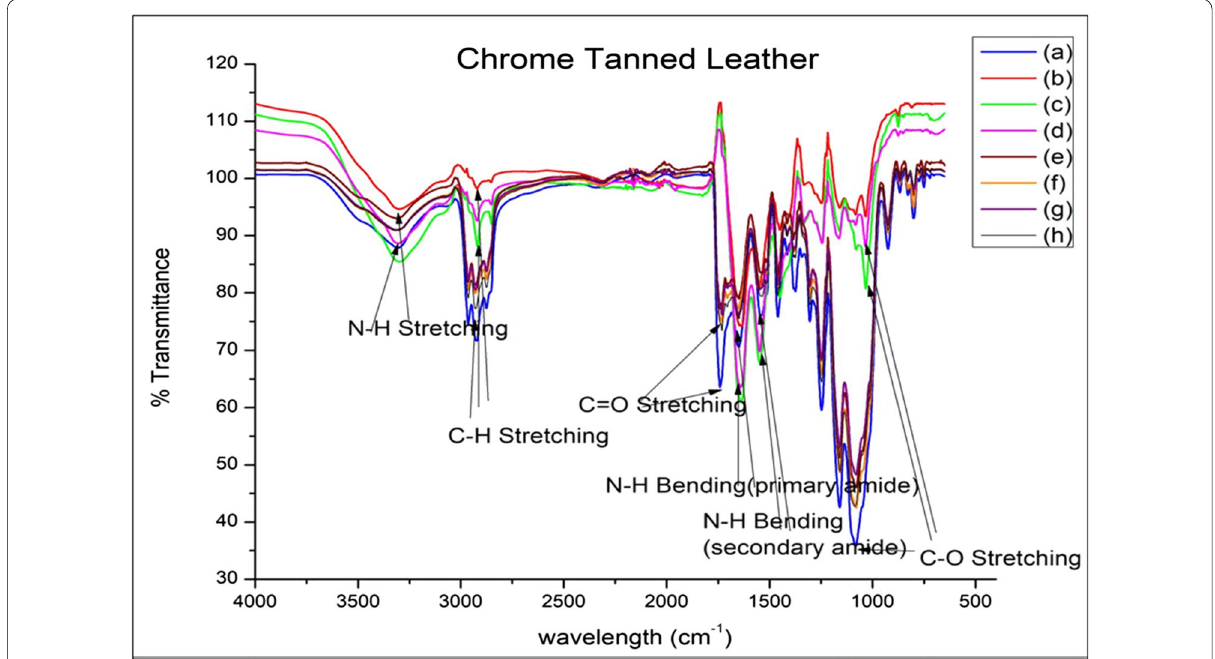
Fig. 4 FT-IR spectra of chrome tanned leather samples after 30 days’ incubation a control sample without fungi and UV exposure, b A. niger infected leather, c A. flavus infected sample, d control sample with only UV-C exposure for 60 min, e sample exposed for 60 min of UV-C and initially infected by A. niger , f sample exposed for 15 min of UV-C and initially infected by A. niger , g 60 min of UV-C exposure and initially infected by A. flavus sample and h sample exposed for 15 min of UV-C exposure and initially infected by A.